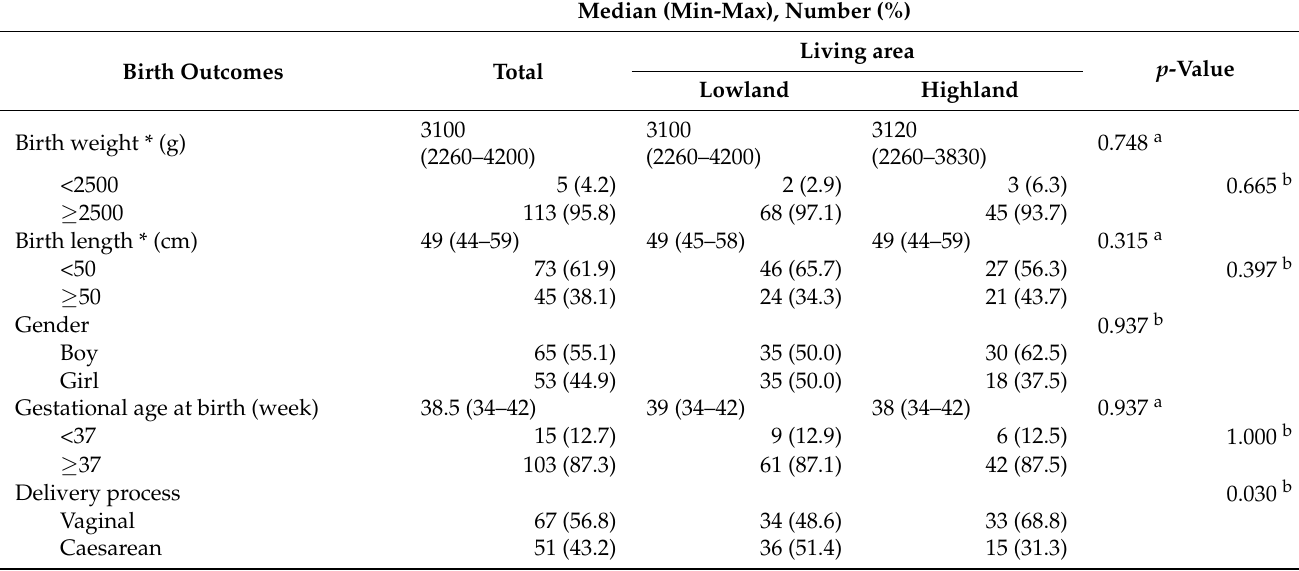
Table 2. Newborn characteristics of the study population.